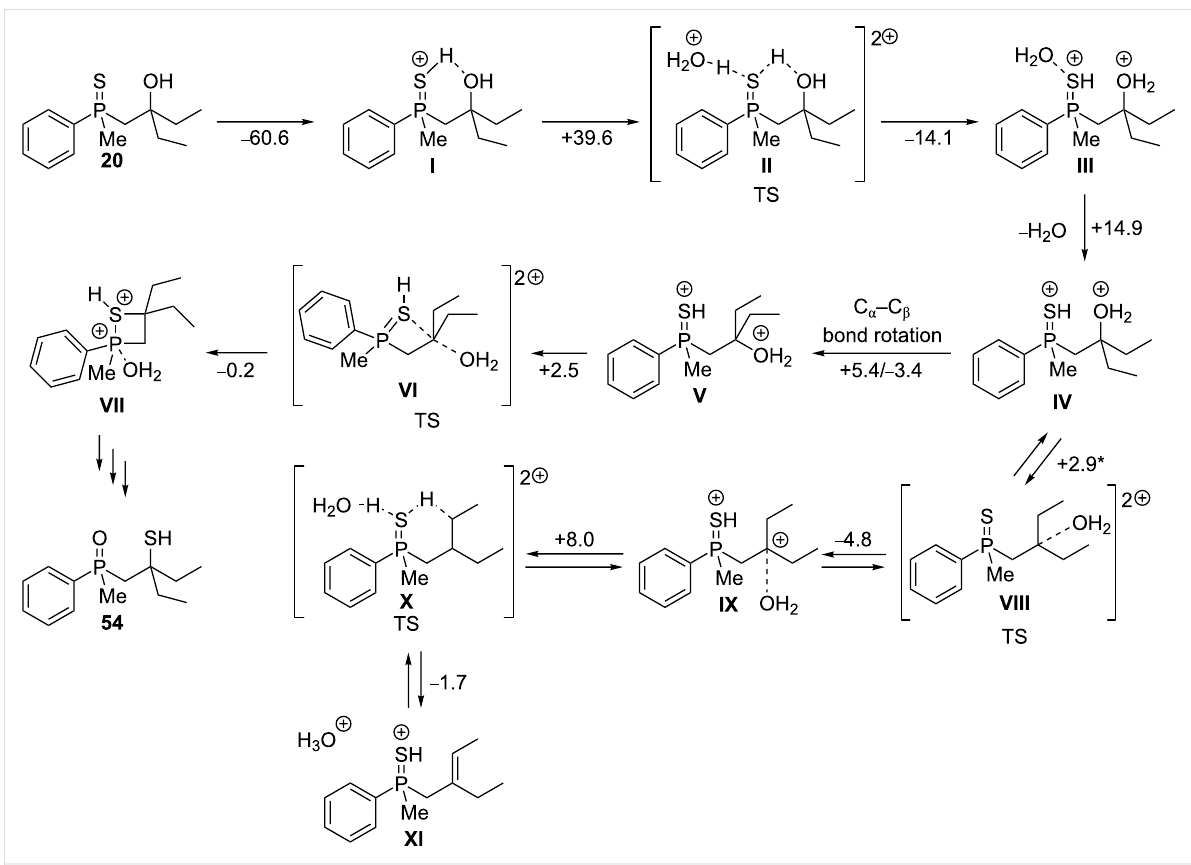
Scheme 9: Rearrangement of 20 in the presence of Brønsted acid. The calculated energies next to the arrows are reported in kcal/mol.